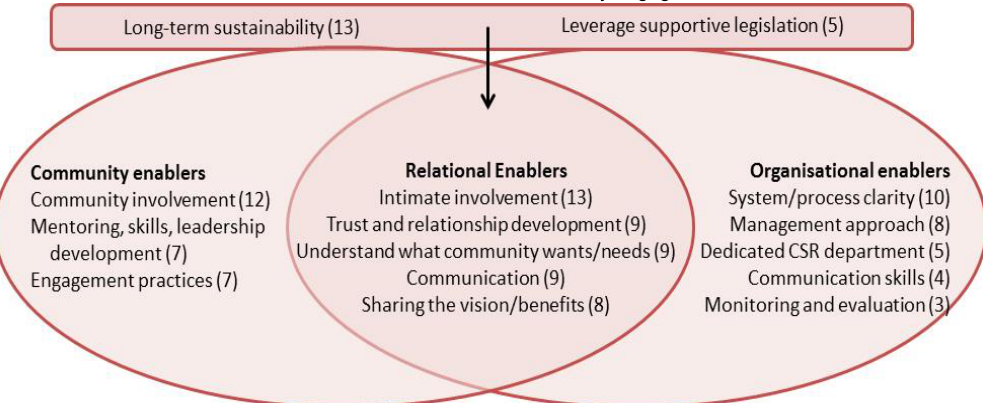
Enablers for transformational community engagement